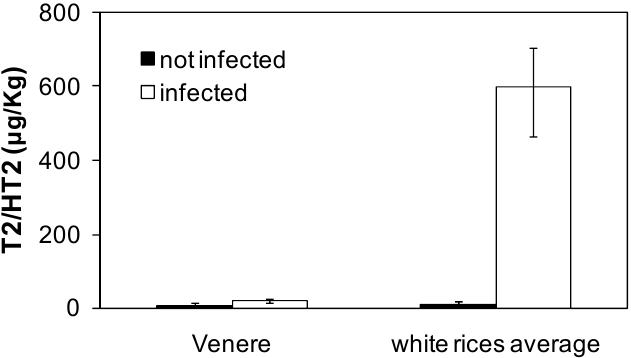
Figure 4. Accumulation of T-2/HT-2 toxins in dehulled caryopses of Venere (black caryopsis) with respect to the average of values obtained in previous tests for white-grained cultivars. As before, dehulled caryopses were incubated at 10 °C on agar either with or without Fusarium sporotrichioides spores. Toxins were analyzed after 6 days of inoculation. ANOVA showed a significant effect ( p < 0.05; n = 3–10 data for each mean) of both grain type (black/white), treatment (presence/absence of F. sporotrichioides inoculum) and their interaction.